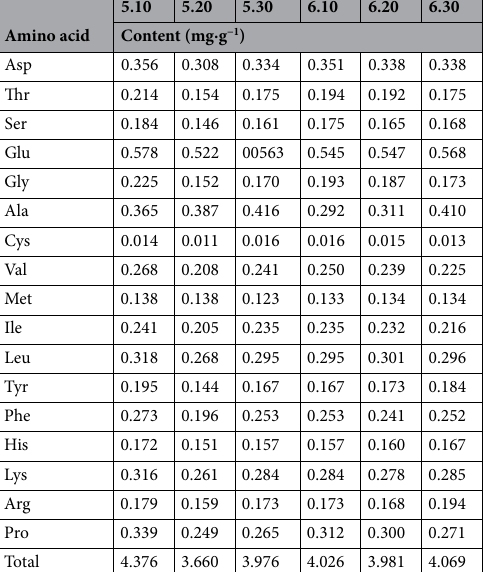
Table 1. Changes in amino acid content in earthworm mucus under different electrical stimuli. 5.10, 5.20, 5.30, 6.10, 6.20, 6.30 indicate 5 V 10 mA, 5 V 20 mA, 5 V 30 mA, 6 V 10 mA, 6 V 20 mA, and 6 V 30 mA,